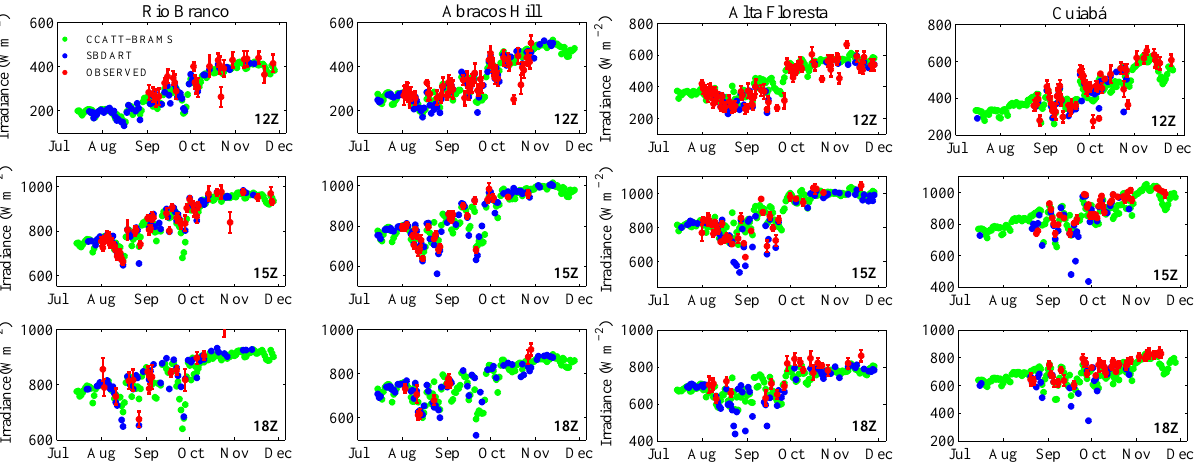
Fig. 6. Modeled (CCATT-BRAMS, SBDART) versus observed downwelling solar irradiance at the surface under cloud-free conditions. SBDART results were obtained using as input aerosol optical depth and column water vapour from